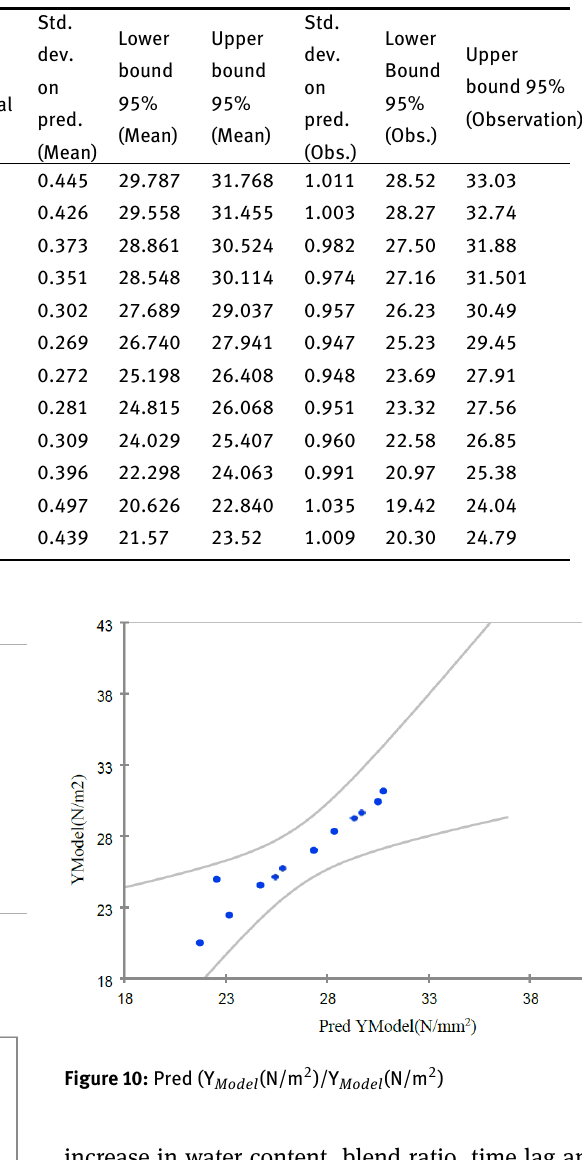
increase in water content, blend ratio, time lag and W/C ratio (Figure 2) It also decreases with the parameter’s ratios like W/C, CA/C, r/C, t/c From Neural Analysis Figure 8 represents that the dependent variable strength is having the main influence of the parameters like C.A, FA, cement and W/C ratio, while the other param- eters like t, r, water, the ratios like FA/C, r/C,CA/C, t/C are not so much significant. From Linear Regression From the lab compressive strength, the model